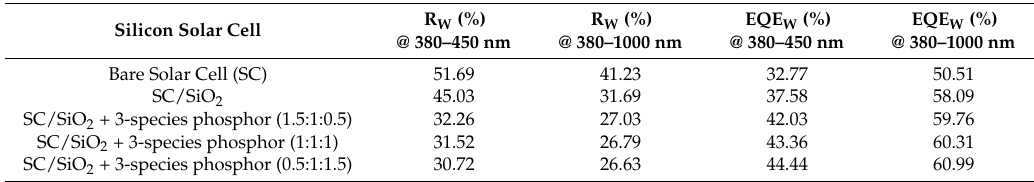
Table 2. Average weighted reflectance (R W ) and average weighted EQE (EQE W ) calculated for wavelengths from 380 to 450 nm and from 380 to 1000